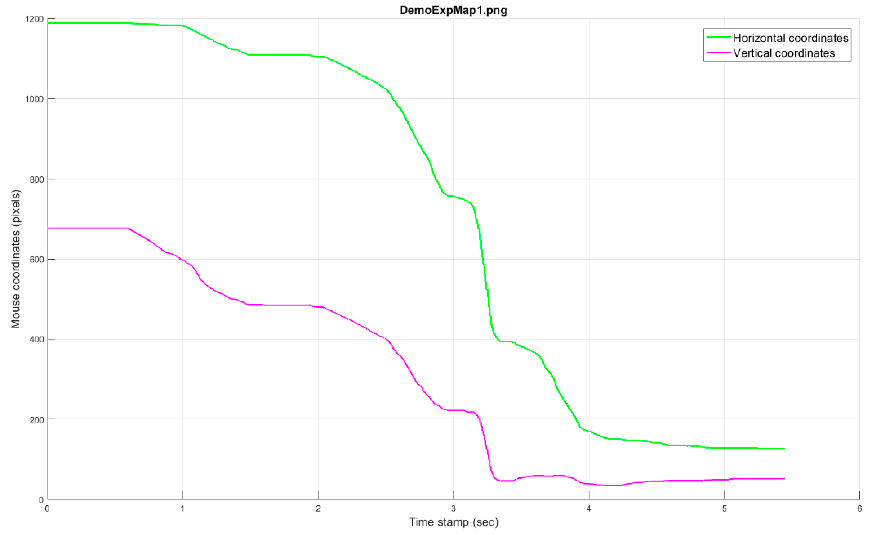
Figure 4. Mouse coordinates (in pixels) vs. elapsed time (in seconds).